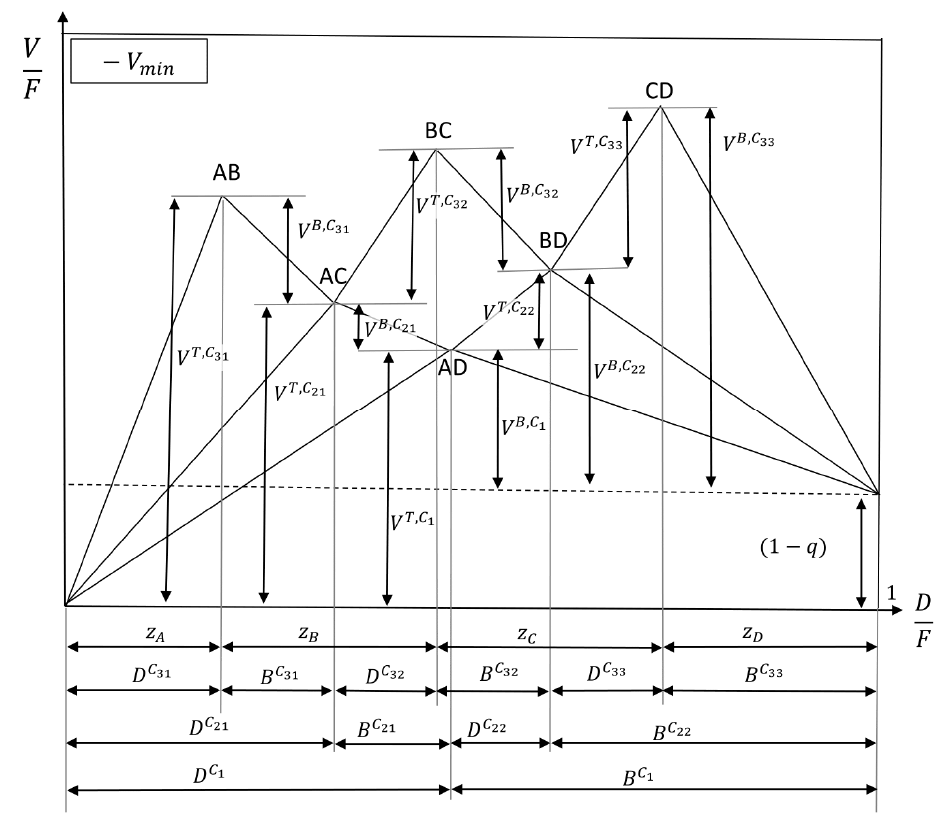
Figure 6. Extracting internal streams from the V min diagram for a four product Petlyuk configuration (adapted after [10]). For the column numbering, see Figure 1b.